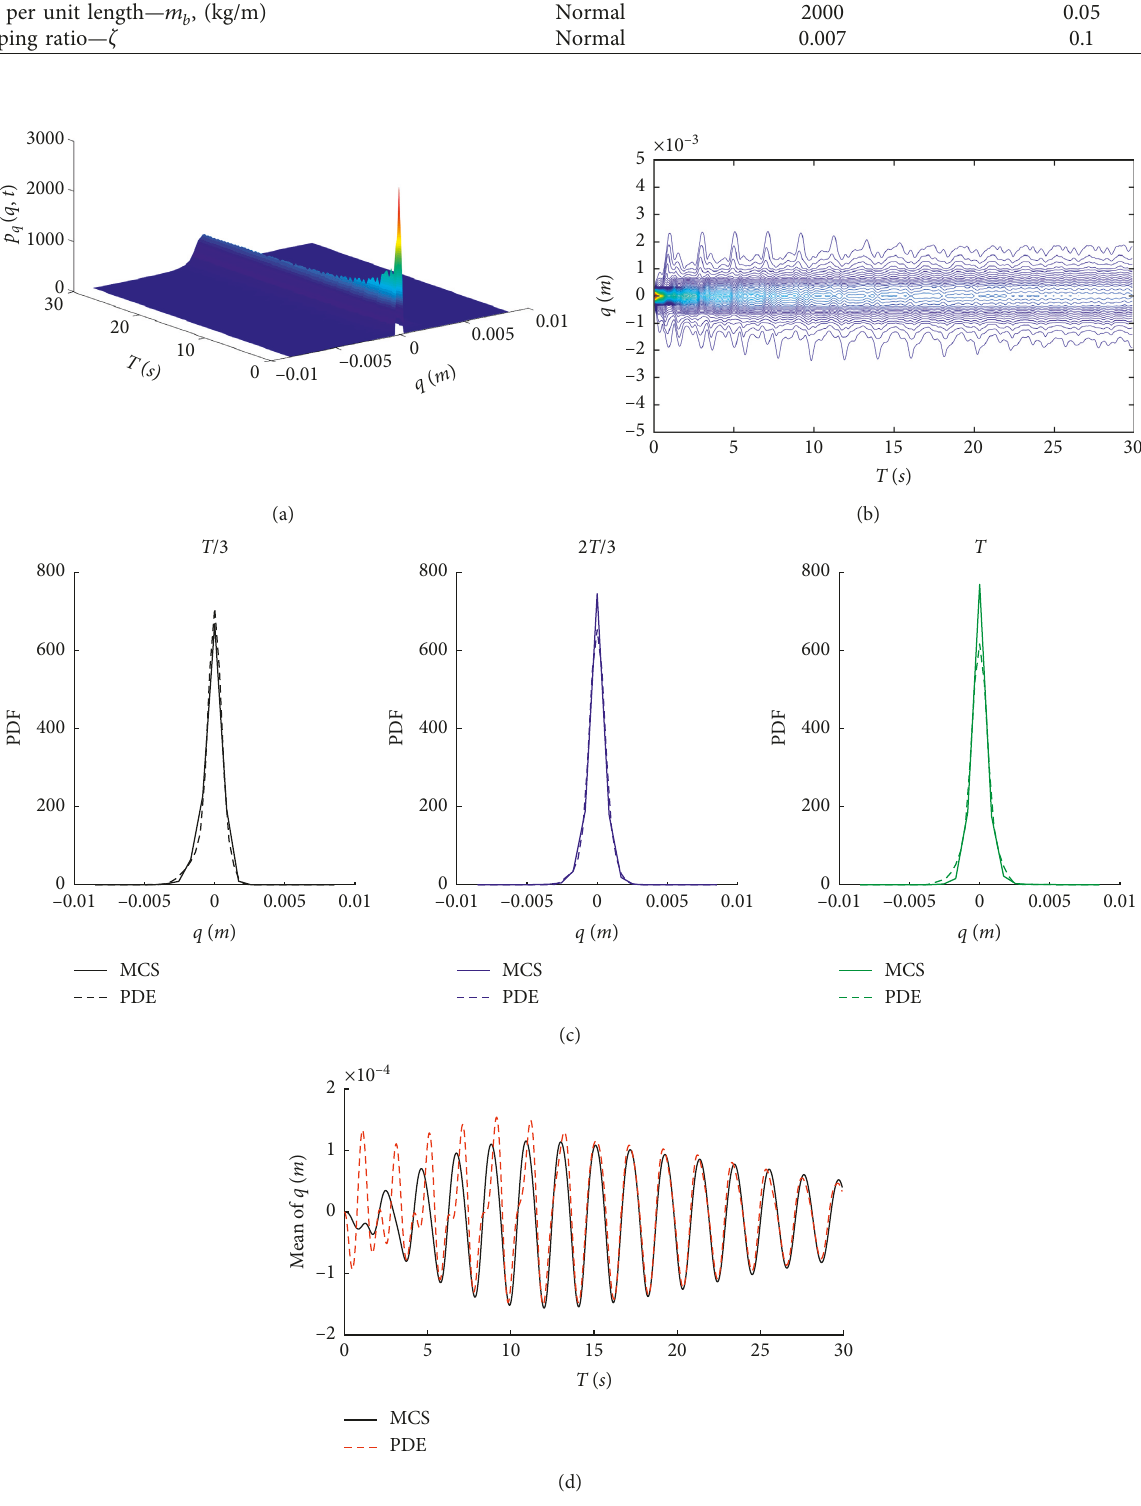
� 120). (a) PDF evolution process ( T � 30s). (b) Contour of the PDF surface p